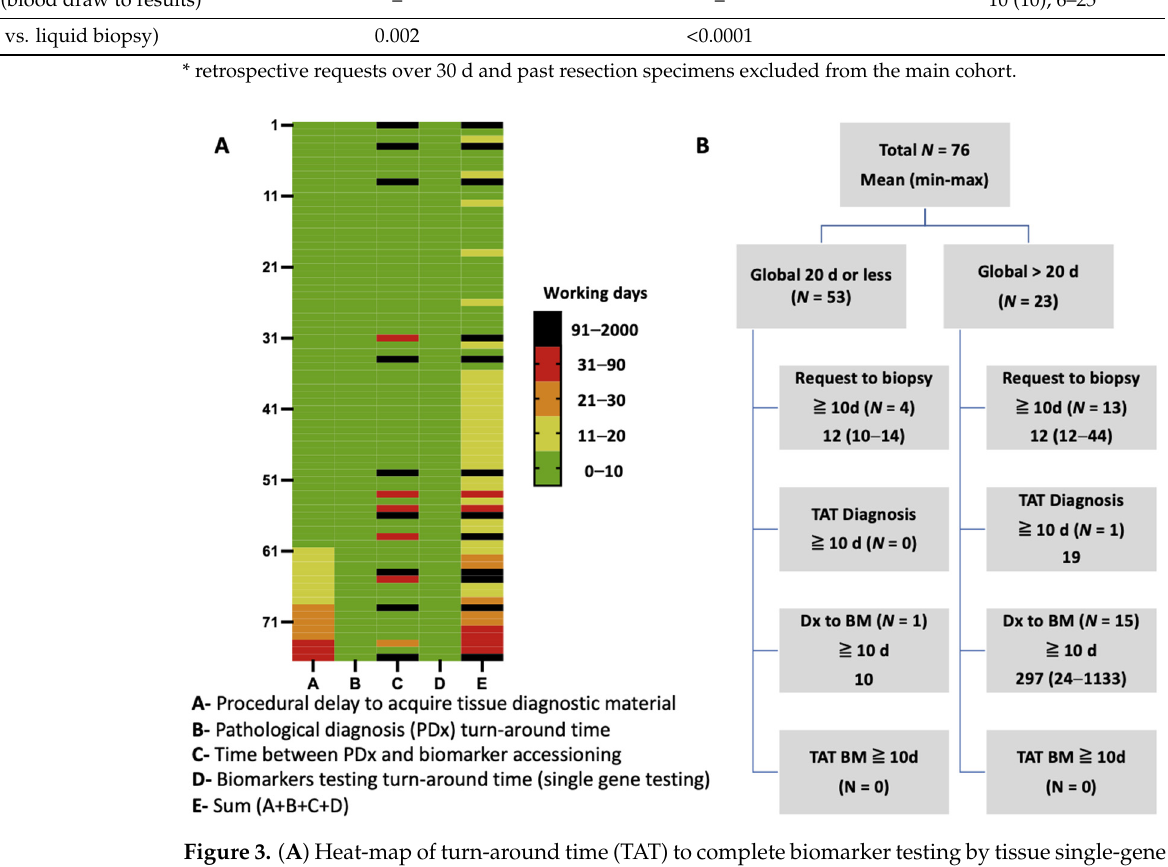
Figure 3. ( A ) Heat-map of turn-around time (TAT) to complete biomarker testing by tissue single-gene testing per main trajectory category (working days). ( B ) Breakdown of samples with full trajectory cumulative turnaround time divided with a threshold of 20 days.